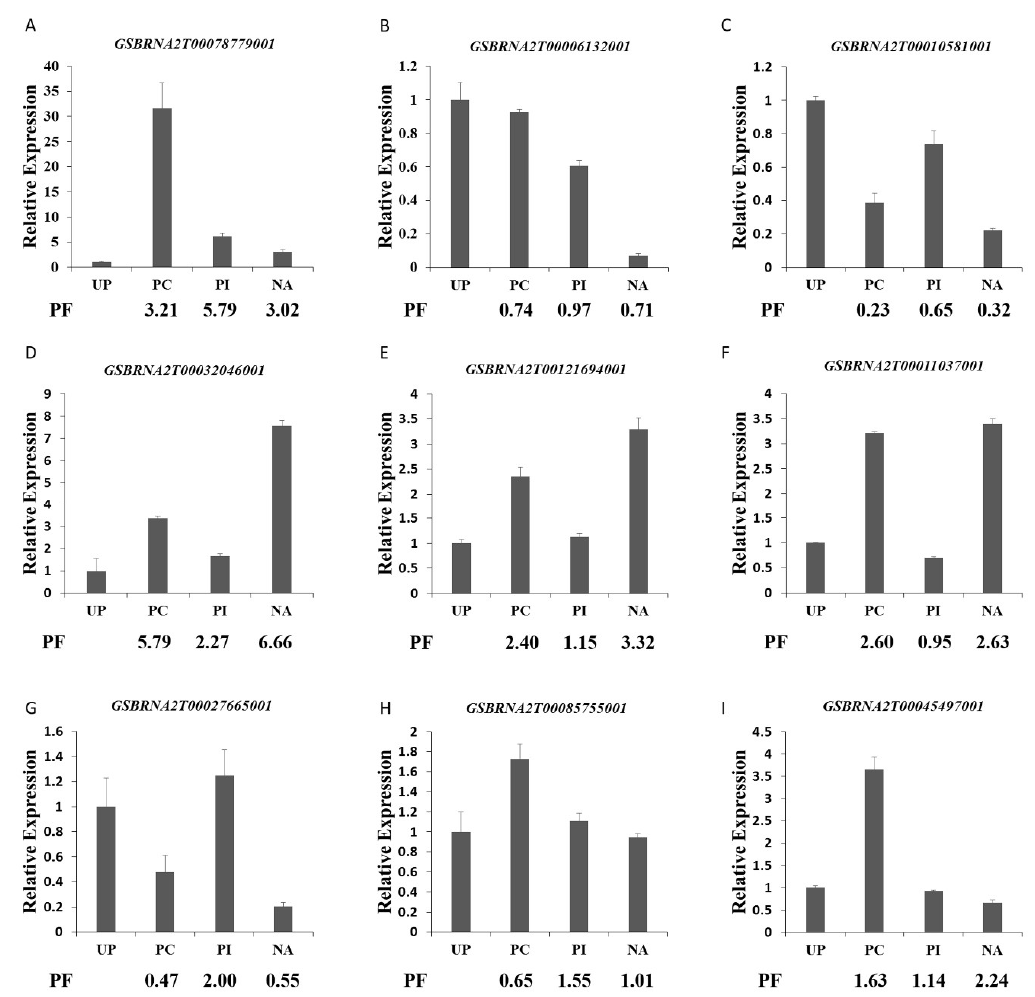
Figure 7. Figure 7. qPCR analysis of the genes selected randomly from differentially accumulated proteins. (A)